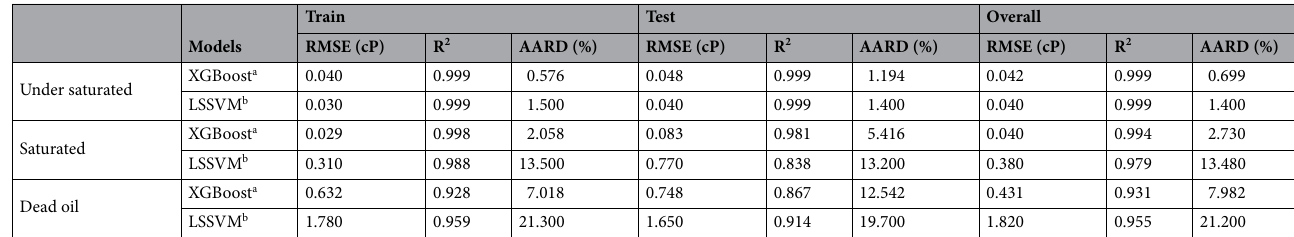
Table 4. Performance of the XGBoost model in comparison with the LSSVM model. a XGBoost model (This Study). b LSSVM model 19 .